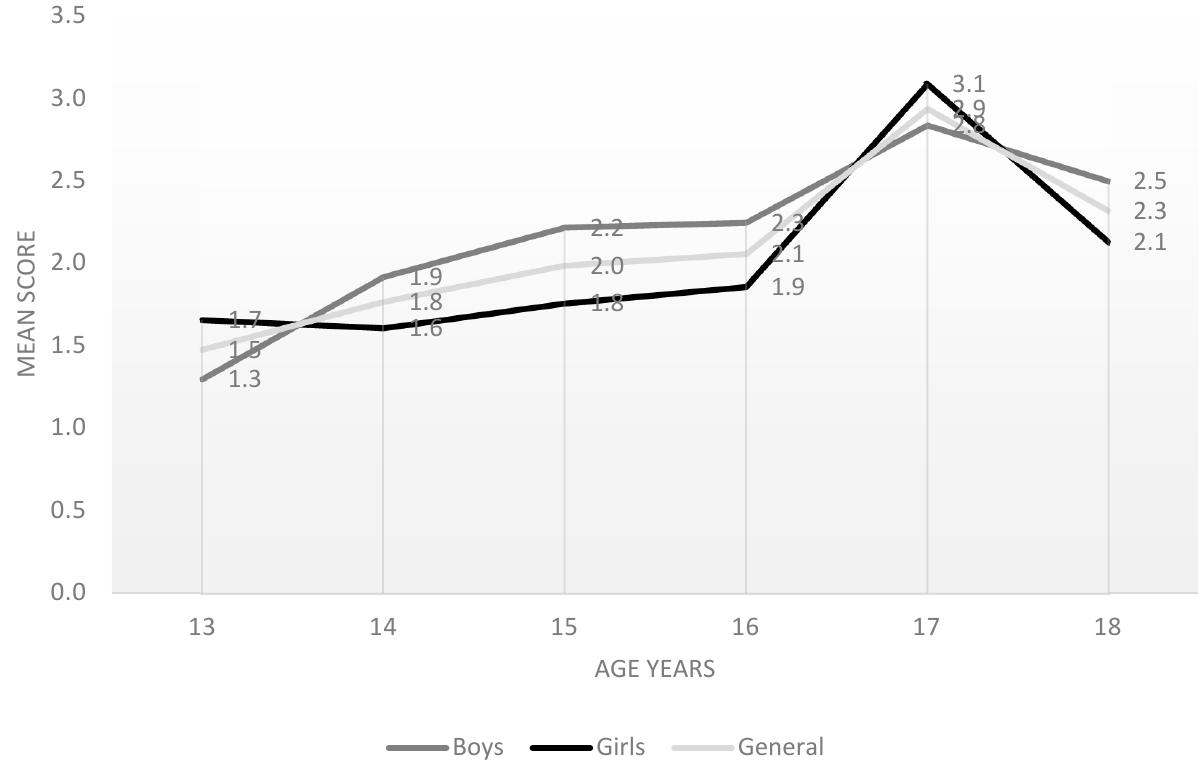
Figure 1. Mean scores by age groups and sexes.